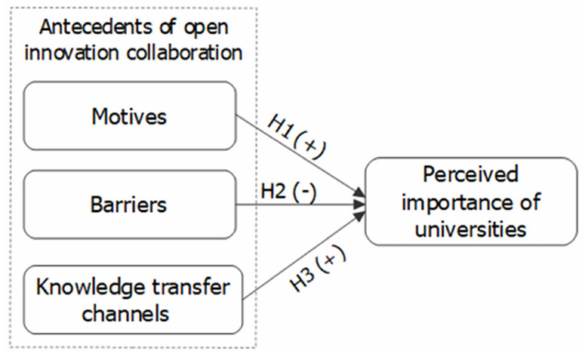
Figure 1. The research